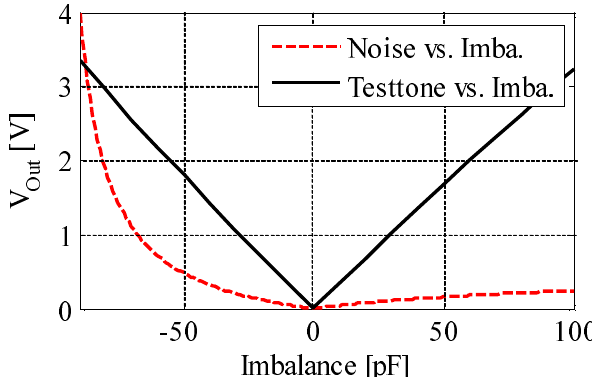
Figure 9. Correlation between the test signal and the electrode—body interface (EBI) imbalance of conventional method and our circuit design. Red dashed curve: with the conventional method